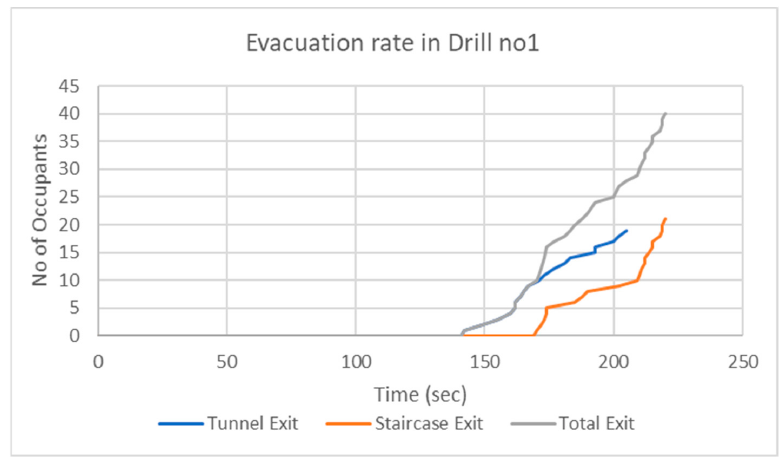
Figure 19. Evacuation rate during the first drill.